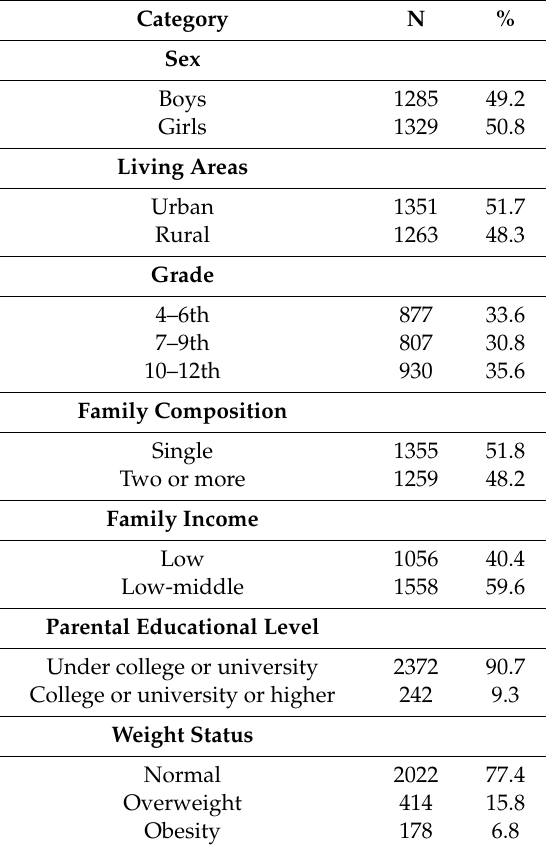
Table 1. Characteristics of the participants in this study ( n =